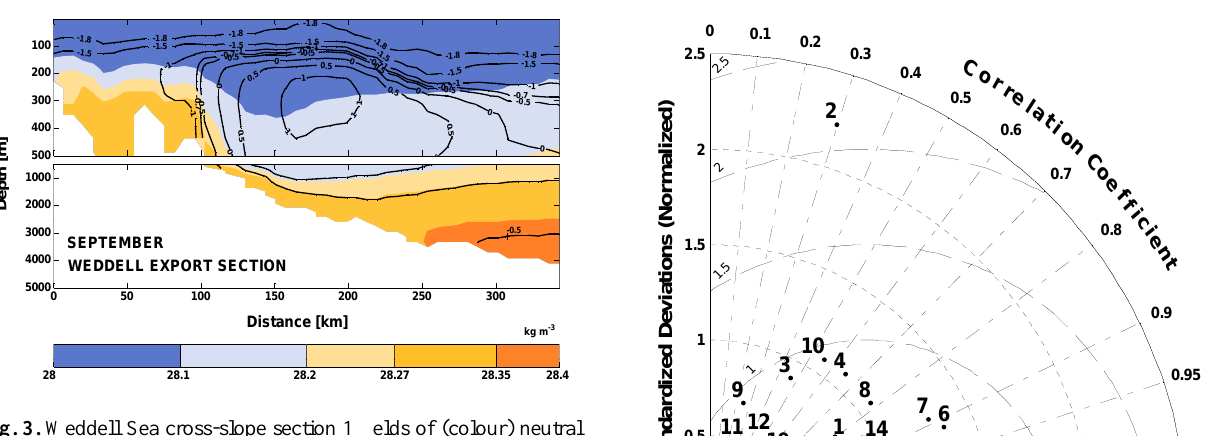
the statistical variables are given by Taylor (2001) and the output displayed in a Taylor diagram (Fig. 4). We used the WOD05 dataset as the reference observations, marked by the point labelled “R”. Both normalised standard deviation ( σ norm = σ model / σ obs ) and correlation coefficient are equal to 1 at the reference point R (Fig. 4). The better the correlation (radiating long-short dashed lines in Fig. 4) and the closer the standard deviation of the modelled data to the observations (short-dashed curves), the closer the corresponding model point will be to the reference point R. The lines of low RMSE values mark the best fit considering both the correlation and the variability pattern. This model-observation bottom-layer statistical comparison through the Taylor diagram